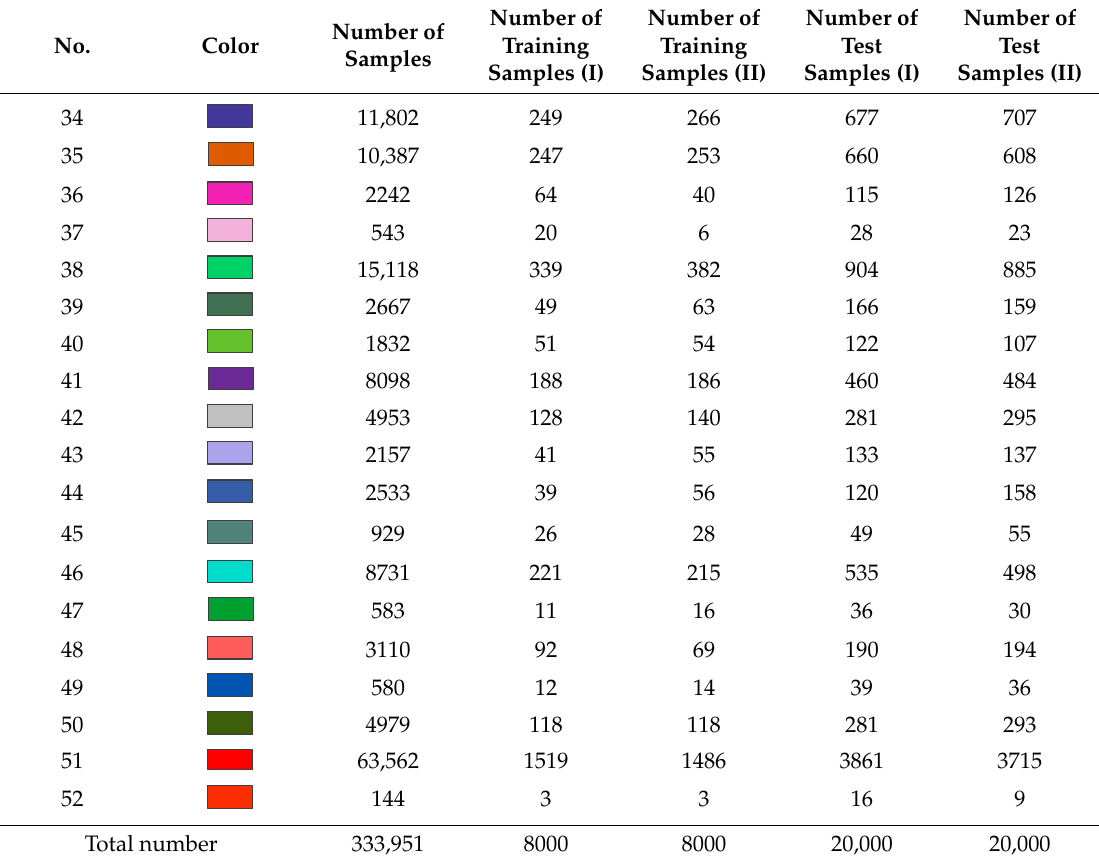
Table 2. The detailed framework of DenseNet.